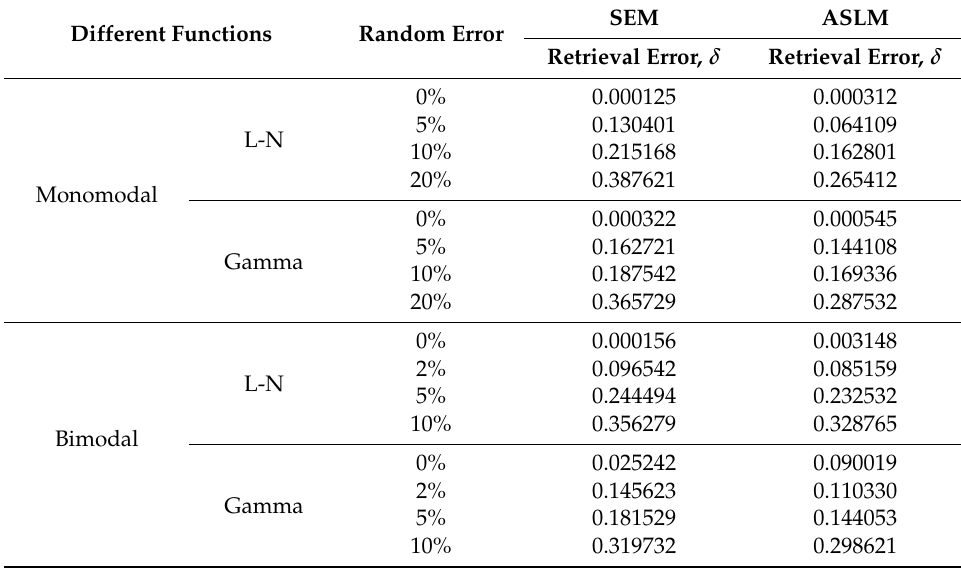
Table 4. Retrieval results of ASDs under different optical measurement methods.